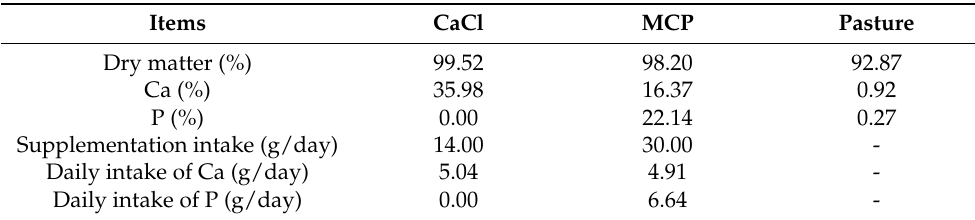
Table 1. The content 1 of calcium (Ca) and phosphorus (P) in pasture, calcium chloride (CaCl), and monocalcium phosphate (MCP; air-dried basis). Items CaCl MCP